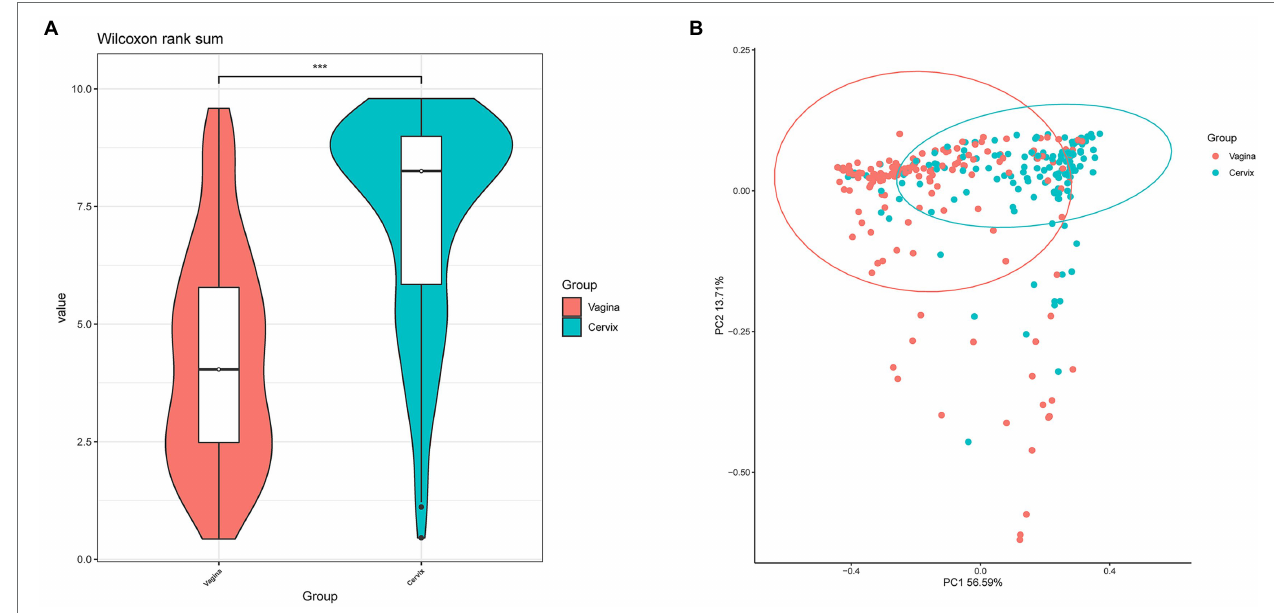
FIGURE 3 | Differences between cervical and vaginal microbiota. (A) The Shannon diversity indices of vaginal and cervical microbiota. (B) A principal coordinates analysis (PCoA) based on weighted UniFrac distance metrics was applied to represent the distribution of the vaginal and cervical microbial communities.